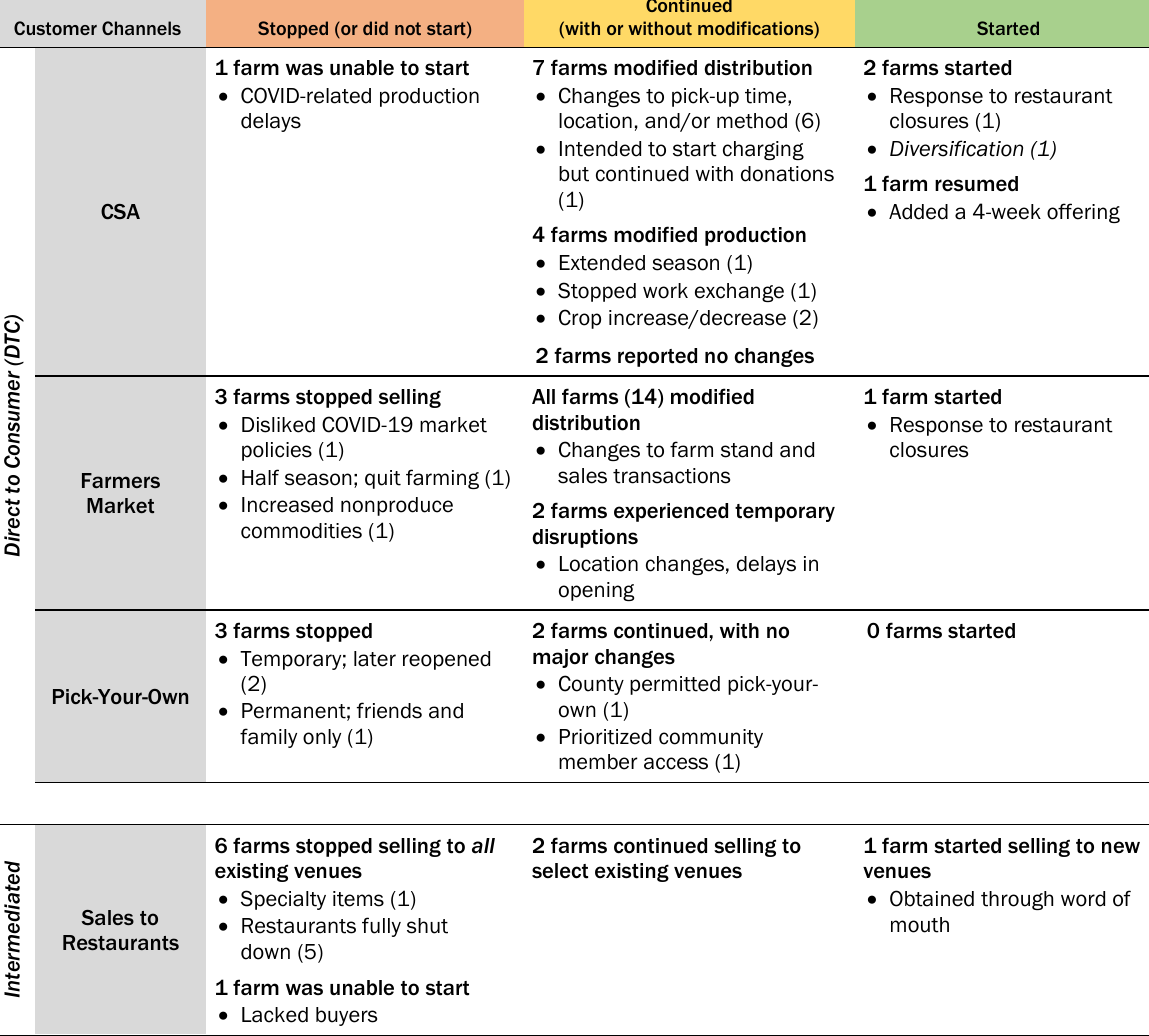
Figure 2. Farmer Responses to the COVID-19 Pandemic by Direct Marketing Channel Customer